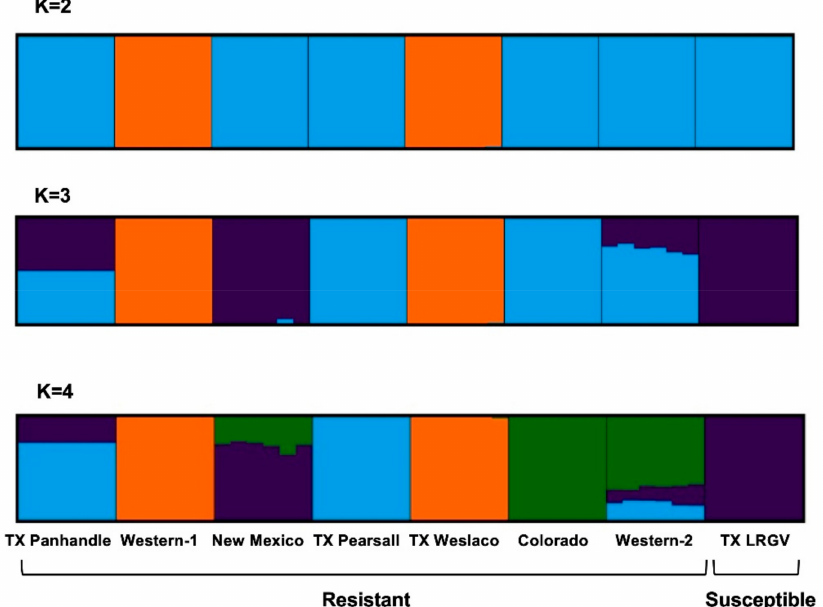
Figure 4. Cluster assignment of the individuals revealed by Structure. Each individual is represented by a single column divided into K genetic clusters. K indicates the number of clusters that maximized the probability of the model. The color proportions of each bar correspond to individuals’ estimated membership fractions of each of the